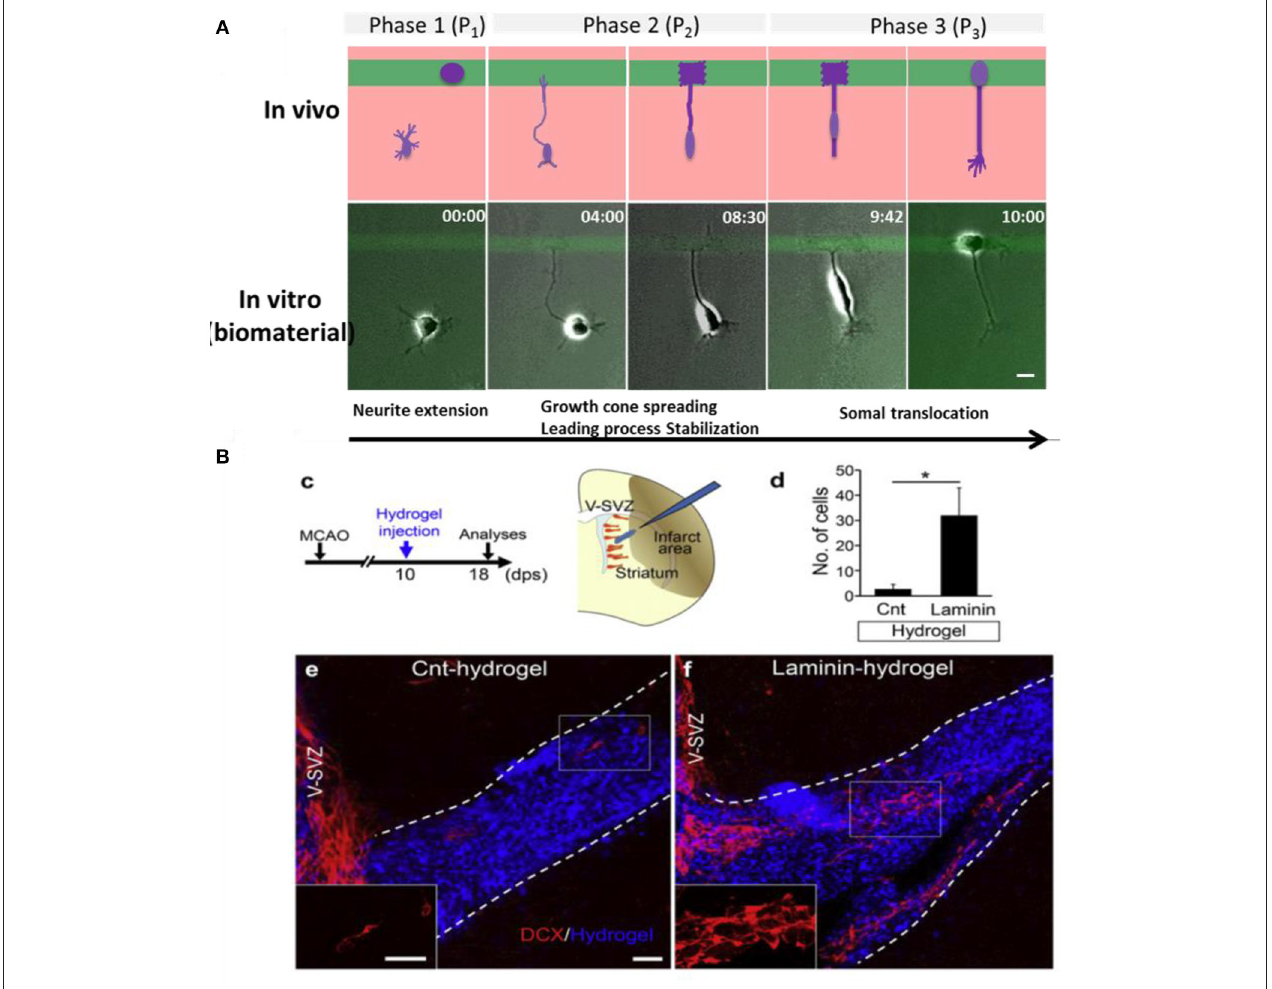
FIGURE 5 | Neuronal migration on biomaterials. (A) Hydrogel coated glass slides modified with mircopatterens of PL/IKVAV to trigger neuronal migration and somal translocation of cortical neurons in vitro ( Zhao et al., 2017) Copyright 2017, Elsevier; (B) Migration of neuroblasts along a LN coated hydrogels toward the injured area in vivo (Fujioka et al., 2017) Copyright 2017,